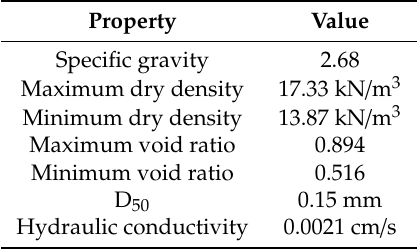
Table 4. Characteristics of Nevada Sand (Taboada and Dobry (1998)